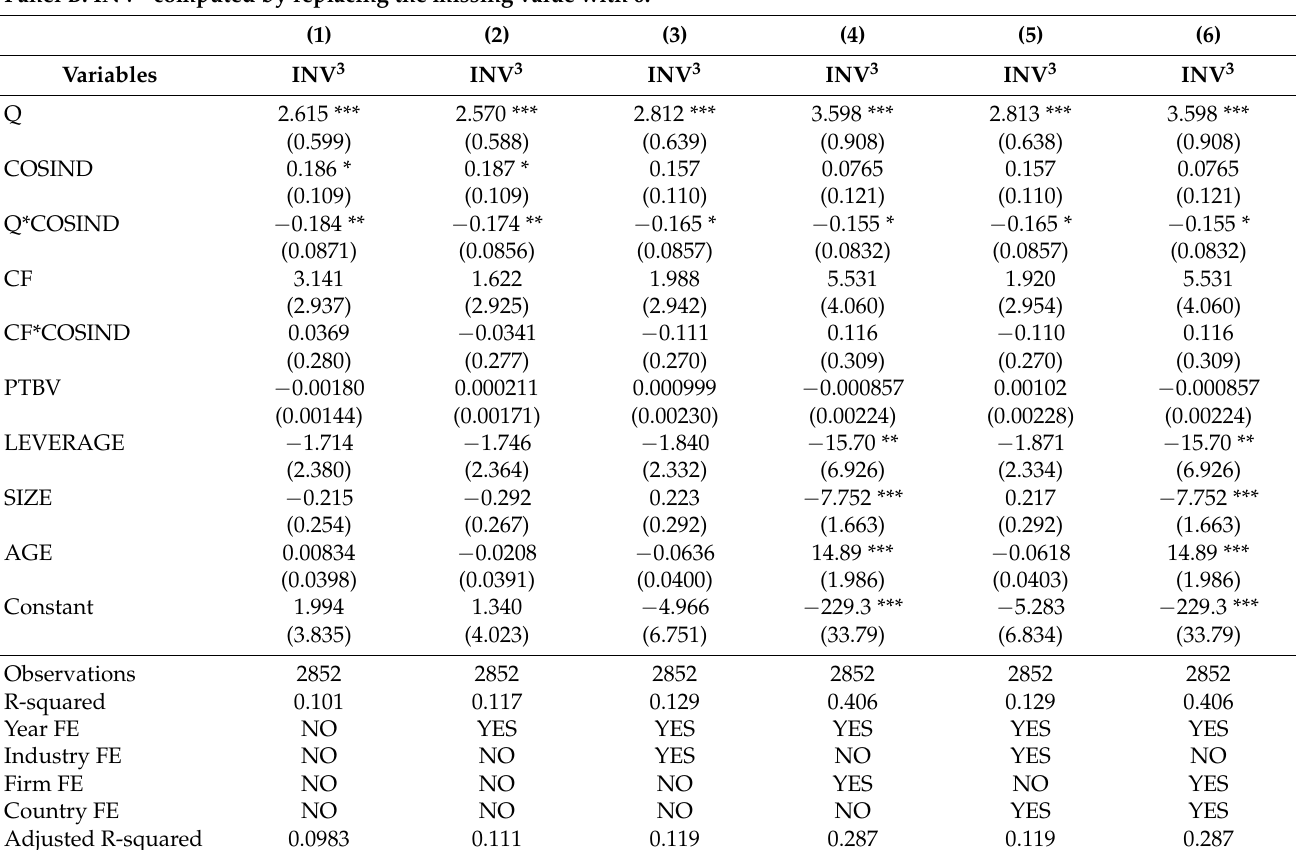
Table 7—Panel A shows the results with an alternative measure of the corporate invest- ment rate. The coefficient estimates of Q on INV (row 1) and Q*COSIND (row 3) indicating the marginal effect of Tobin’s Q on corporate investment are positive and significant